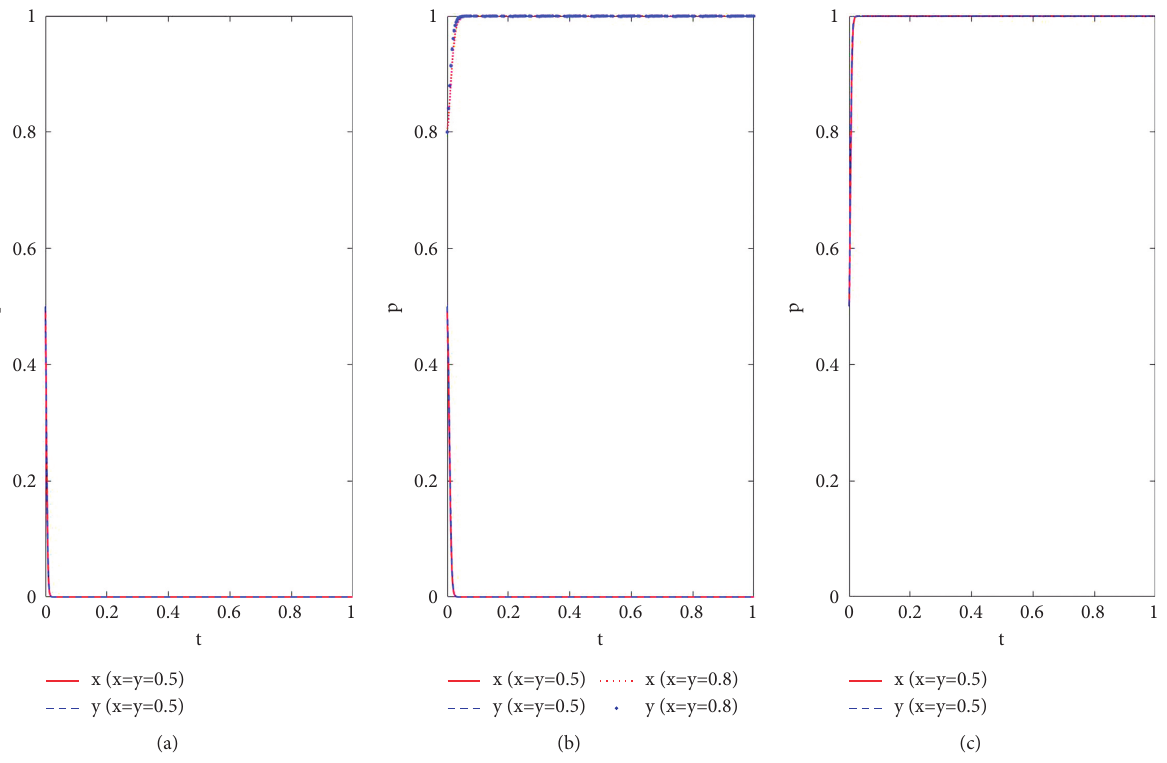
Figure 4: Evolution process of game system with government participation.